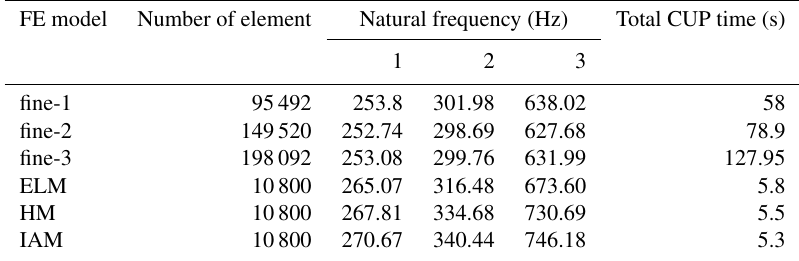
Table 3. Comparison of the first six natural frequencies of the honeycomb panel. FE model